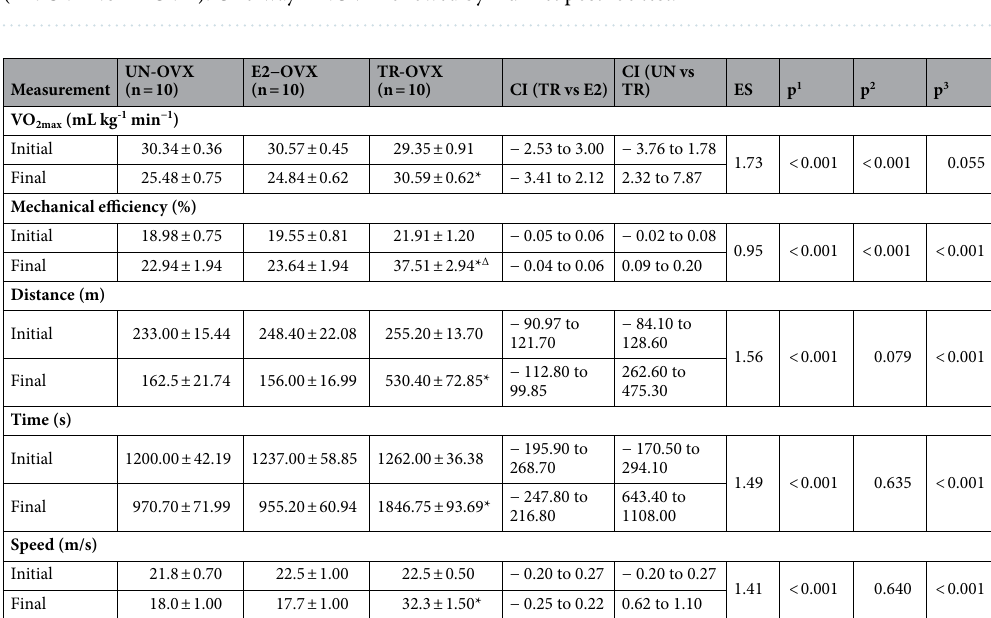
Table 1. Aerobic capacity. Data are presented as mean ± S.E.M. 95% confidence interval (CI). untrained ovariectomized rats (UN-OVX), ovariectomized rats treated with Estradiol replacement (E2-OVX), and trained ovariectomized rats (TR-OVX). VO 2max : maximal oxygen consumption. N = 10 per group. Effect size (ES). p1 interaction, p2 time, p3 treatment. *TR-OVX vs UN-OVX and E2-OVX. ∆ TR-OVX Final vs TR-OVX Initial. Two-way ANOVA followed by Dunnet posthoc test.